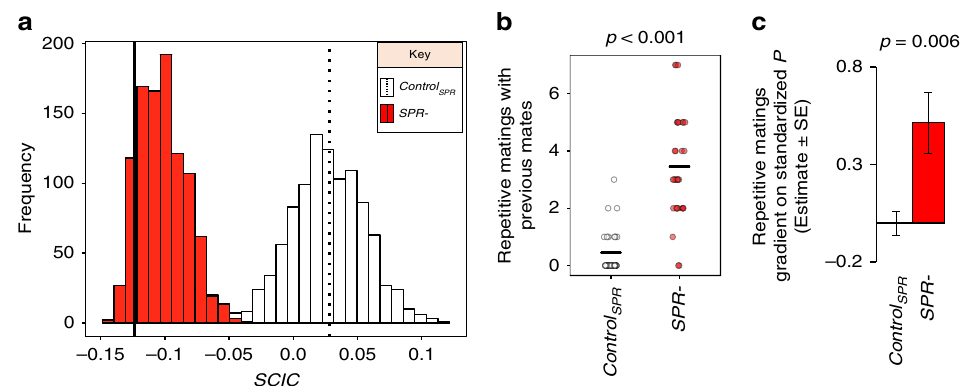
Fig. 3 Mechanisms by which polyandry modulates pre- and post-copulatory episodes. a Stacked frequency plot showing the simulated null distributions of sperm competition intensity correlation (SCIC) values generated from 1000 randomisations of empirical mating data for SPR − and control populations. Vertical lines highlight the observed SCIC value in our experiment. Dashed for SPR − treatment; solid for controls. Treatments differ in the range of SCIC values generated by randomisations, as a result of differing levels of polyandry between treatments. Observed values do not lie outside the range of values expected under the null hypothesis of random mating. b Average focal male ’ s repetitive mating with same female (mean ± SE). P value obtained from a F test of a GLM model. Horizontal black line represents the mean of the data. c Repetitive mating gradient on mean-standardised P . P value obtained from a Student's t -test of a Linear Regression Model. Sample sizes: N = 27 for control SPR and N = 29 for SPR − treatment. Estimate — the estimate of the gradient. Error bars in c refers to the standard error of the mean (SE). White colour refers to control SPR treatment; red refers to the SPR −